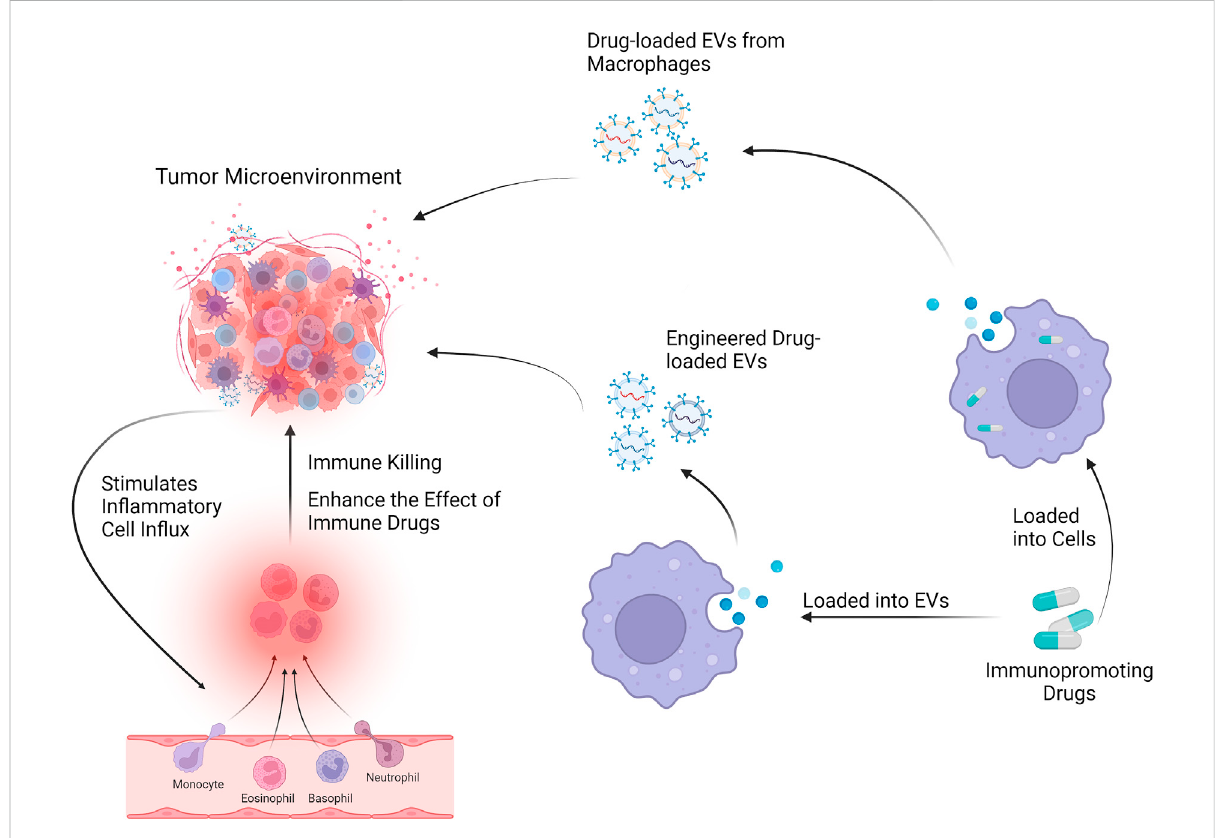
FIGURE 3 M φ s-EVs can be loaded with drugs and will affect the tumor microenvironment through drug delivery systems and engineered